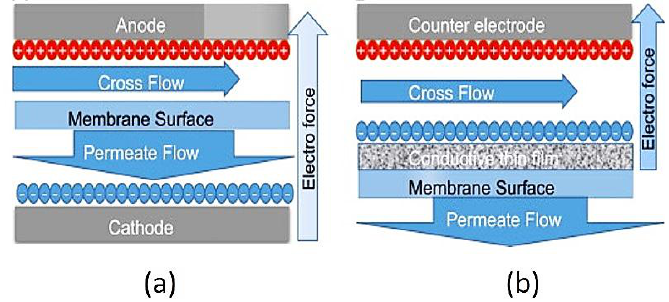
Figure 8. Electro-filtration set-up with: ( a ) conventional and ( b ) conductive membranes. Reprinted from [124], with permission from Elsevier.